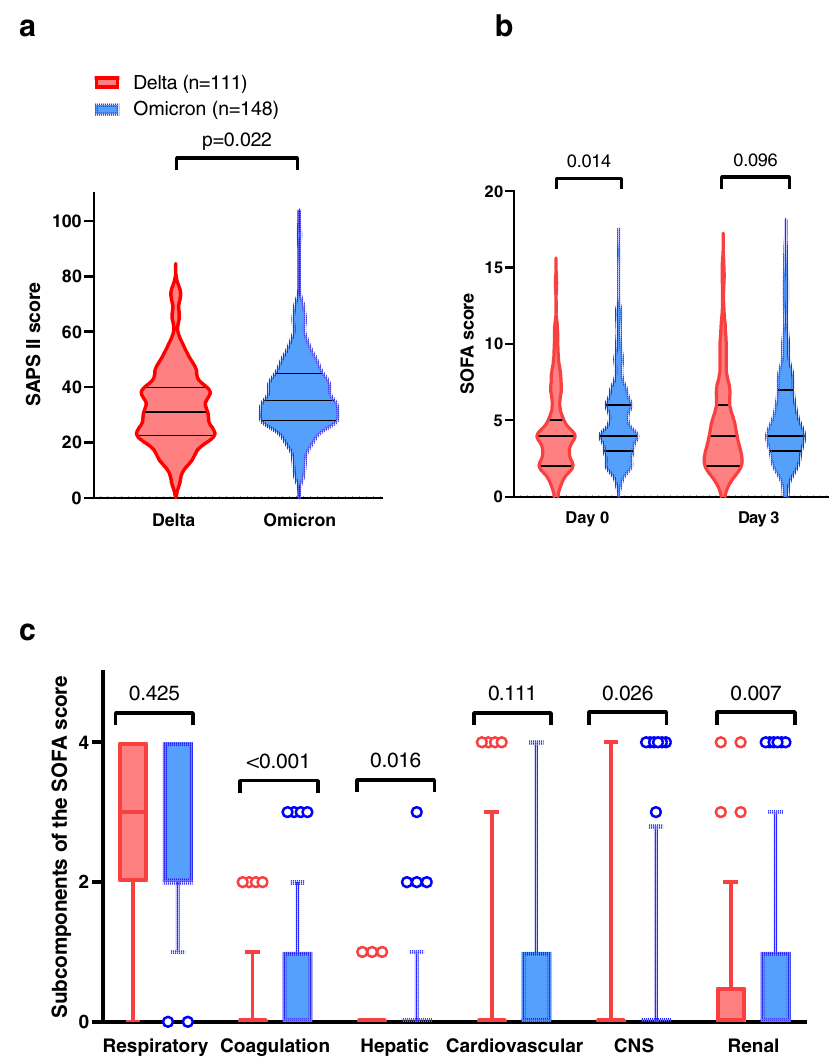
Fig. 2 | Severity of illness scores in patients infected with variant Delta (red; n =111) and variant Omicron (blue; n =148). a SAPS II scores at ICU admission; b SOFA score at day 0 (admission at the ICU) and day 3 of hospitalization (by two- wayANOVA,therewasasigni fi canteffectof thevariant( p =0.0269),nosigni fi cant effect of time ( p =0.2784), and no signi fi cant interaction of both parameters (var- iantxtime; p =0.7668)).In( a )and ( b ),datadistributionis representedusing violin plotsandhorizontalbarsshowthemedianandquartiles25and75; c Organsystem